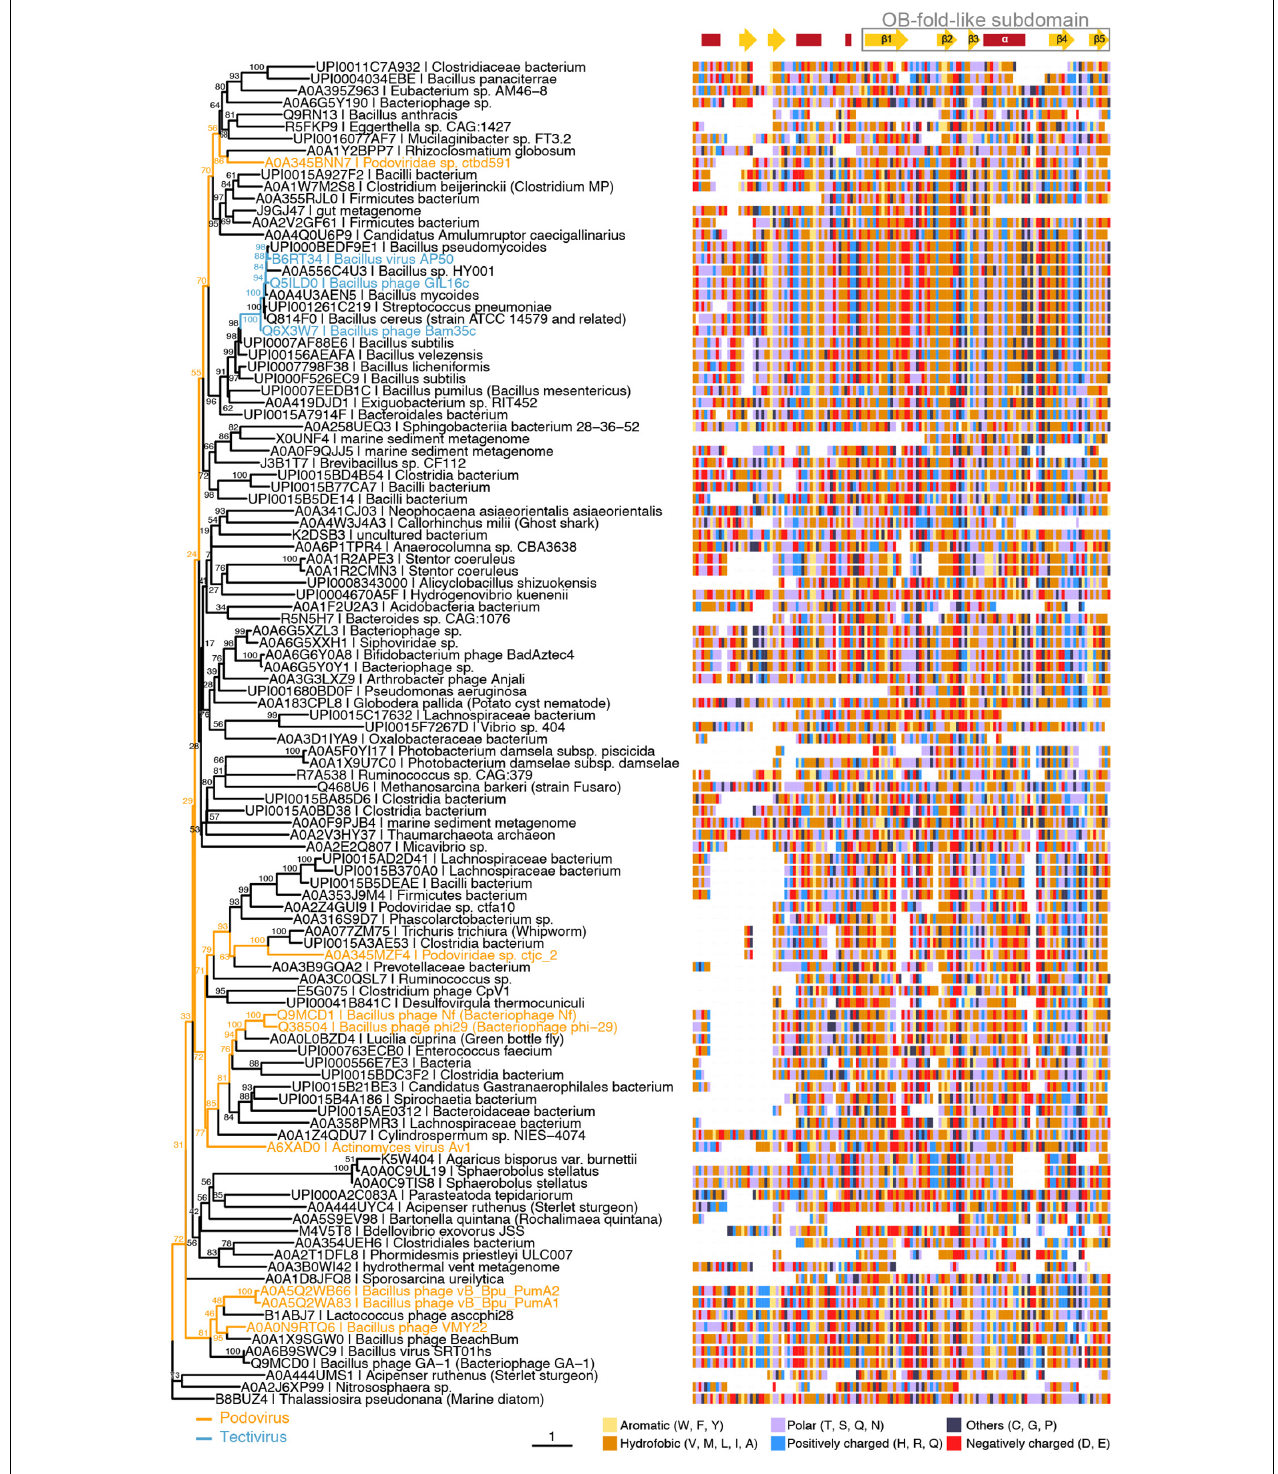
FIGURE 6 | B35SSB and (cid:56) 29 related viruses belong to the same clade of SSBs from protein-primed genomes. Maximum-likelihood tree (left) generated using the trimmed multiple sequence alignment of B35SSB-related proteins (right) and visualized with the ggtree package for R software (Yu et al., 2018). Strain names of phages belonging to Picovirinae (blue) or Betatectivirus (orange) groups are indicated. Secondary structure prediction was obtained with the Jpred4 (Drozdetskiy et al., 2015) and is indicated above the alignment, with the conserved C-terminal region (residues 76–167 in B35SSB) boxed. Residues are colored by their biochemical properties: aromatic (yellow), hydrophobic (orange), uncharged (purple), positively charged (blue), negatively charged (red), others (dark blue).